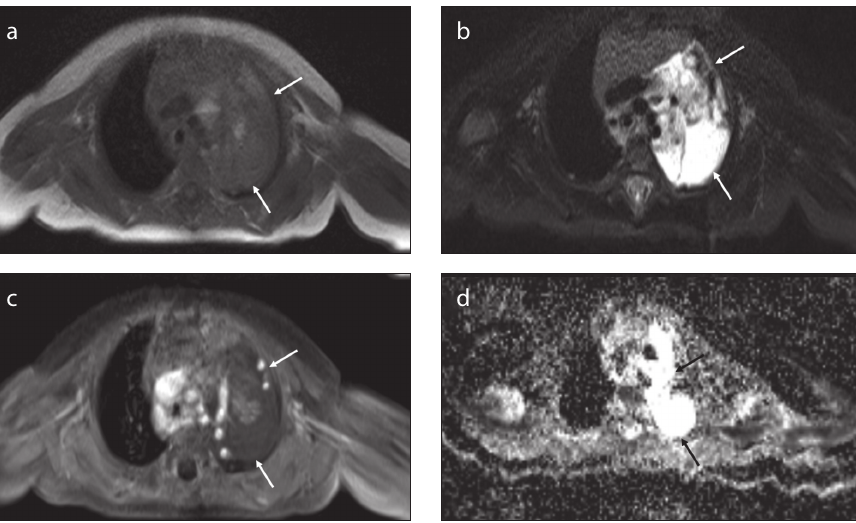
Figure 5. a-d. An 8-year-old male with pathologically confirmed cavernous hemangioma in the left upper lobe. Axial T1-weighted (a) and T2-weighted (b) images reveal the cavernous hemangioma lesion (white arrows). Axial postcontrast-enhanced T1-weighted image (c) reveals peripheral and internal contrast enhancement in the cavernous hemangioma lesion (white arrows). Axial diffusion- weighted (ADC map) image (d) reveals no diffusion restriction (white arrows).